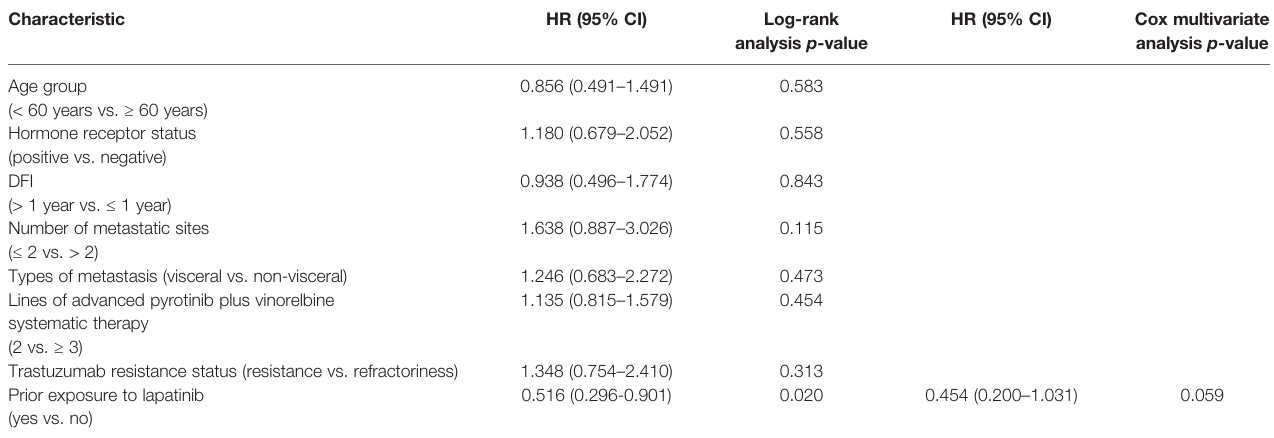
TABLE 4 | Log-rank and cox multivariate analysis of factors associated with progression-free survival.